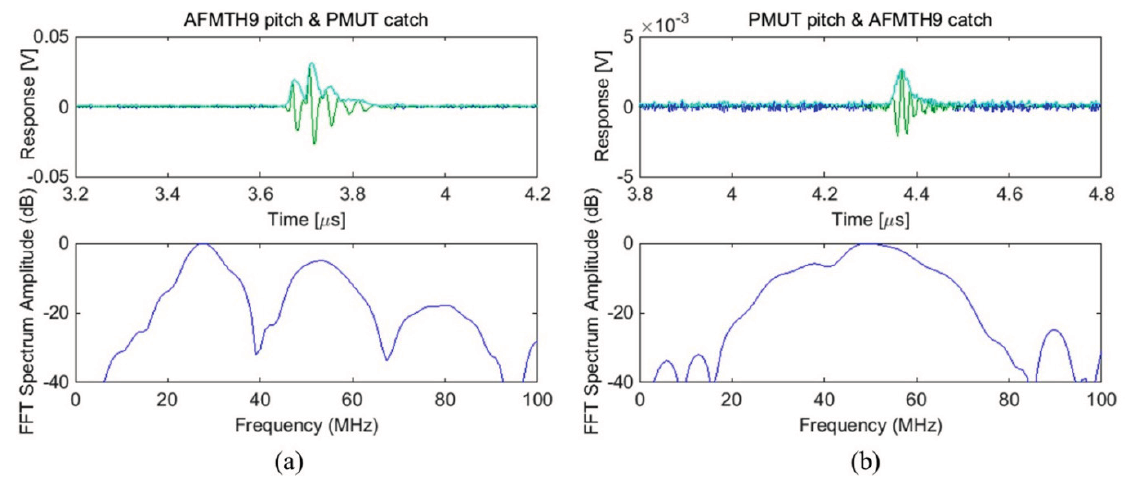
Figure 11. ( a ) Receive and ( b ) transmit response of one element in a PMUT array measured with a 30.5 MHz piezocomposite transducer in deionized water. In the time-domain figures, the blue curve represents original signal with green part of Tukey-windowed signal, and the cyan curve represents Hilbert transformed signal; in the